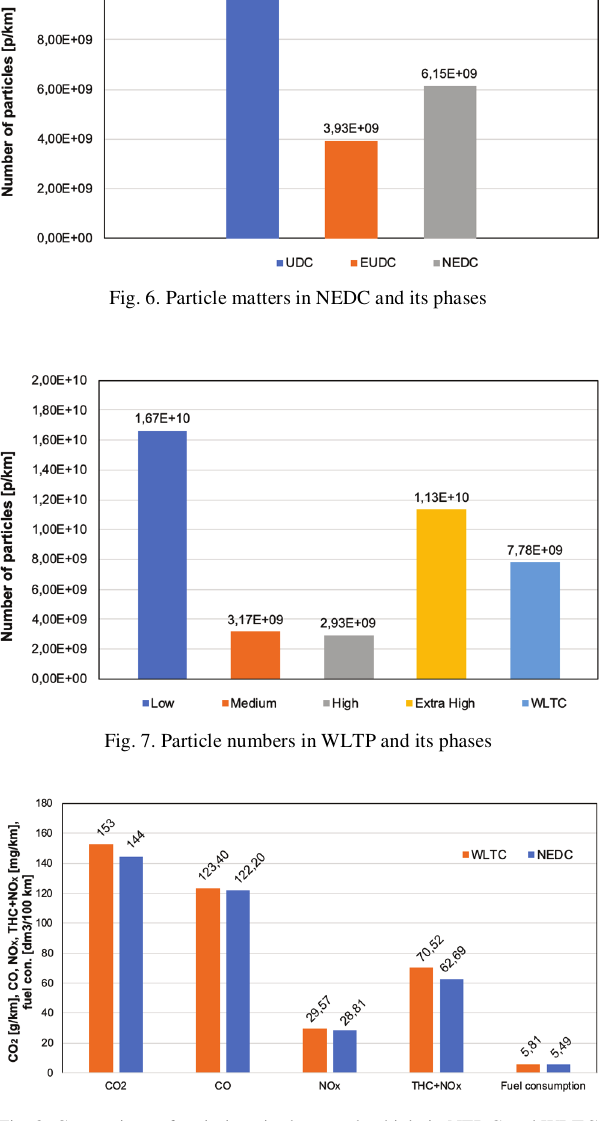
Fig. 8. Comparison of emissions in the tested vehicle in NEDC and WLTC cycles